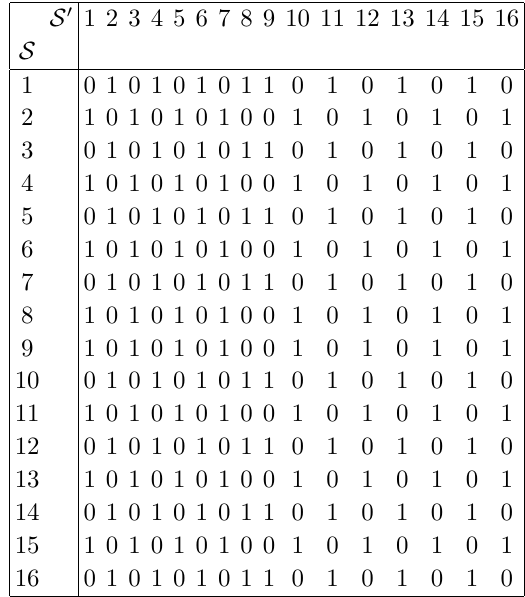
Table 36 . Gadget values for P